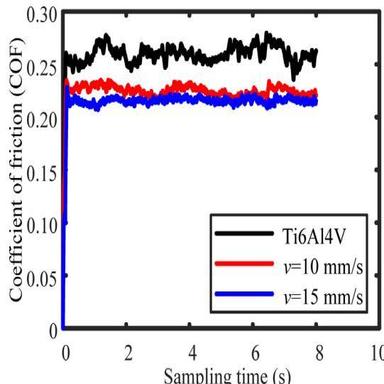
The COF curves of the Ti6Al4V surface, as well as the surfaces with nanoporous structures obtained under different laser scanning speeds (P = 1.48 W, r = 76.6 %, f = 700 kHz): v = 10 mm/s and v = 15 mm/s. The scratch load is kept to 100 mN.